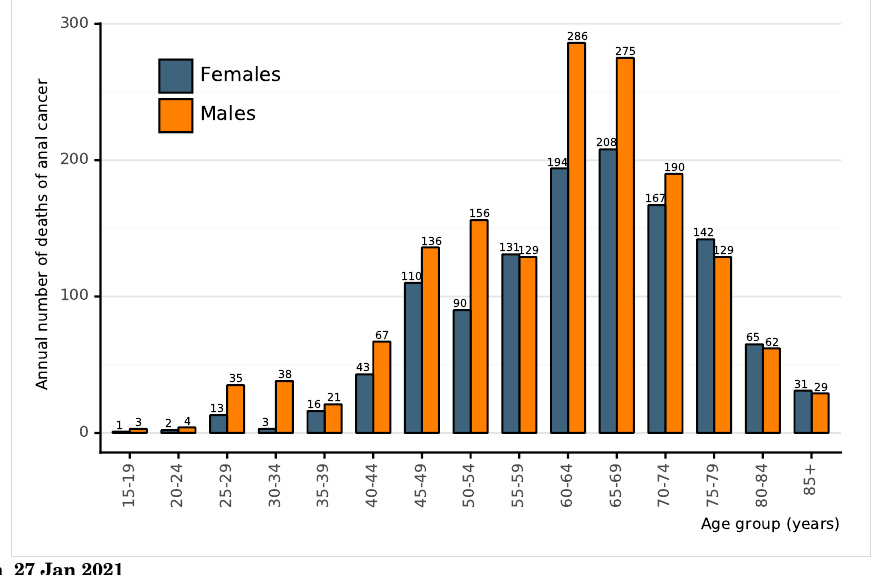
Figure 18: Annual number of deaths of of anal cancer in India (estimates for